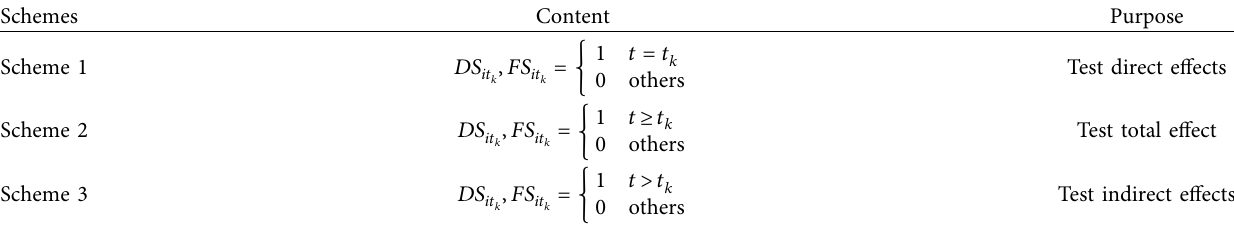
Table 1: Te basic content of the empirical test scheme.